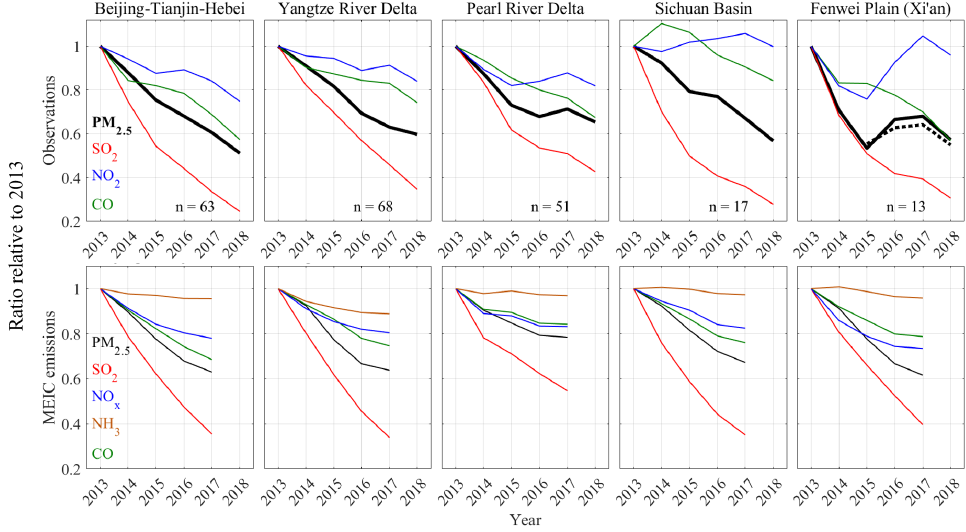
Figure 2. Relative trends of 2013–2018 observed concentrations and 2013–2017 MEIC emission estimates for the five target regions of Fig. 1. The observed PM 2 . 5 trends are shown as thick lines. Values are annual means referenced to 2013. The observed concentrations are averaged over all sites in each region with at least 70% data coverage for each year. The number of sites for each region is indicated. Fenwei Plain trends are for Xi’an, as other sites did not start operating until early 2015. Post-2015 relative PM 2 . 5 trends at these other sites are shown as the dashed line.